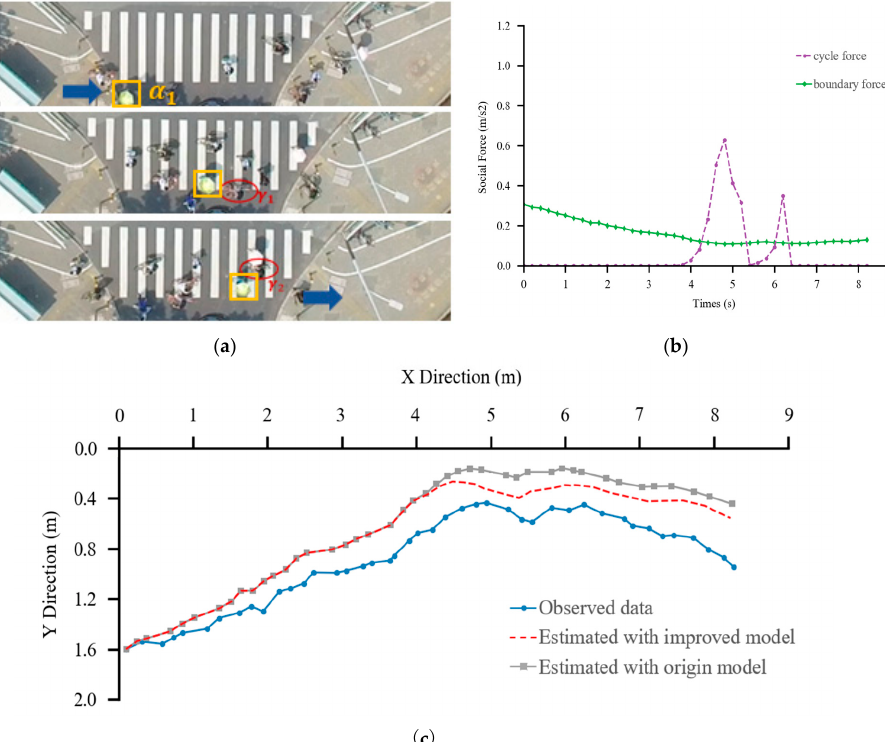
Figure 8. Illustration of the modeled pedestrian movements affected by the boundary and a cyclist. ( a ) The recognized pedestrian and cyclist. ( b ) Forces exerted by the boundary and the cyclist in the improved SFM. ( c ) Comparison of traditional and improved social force models.